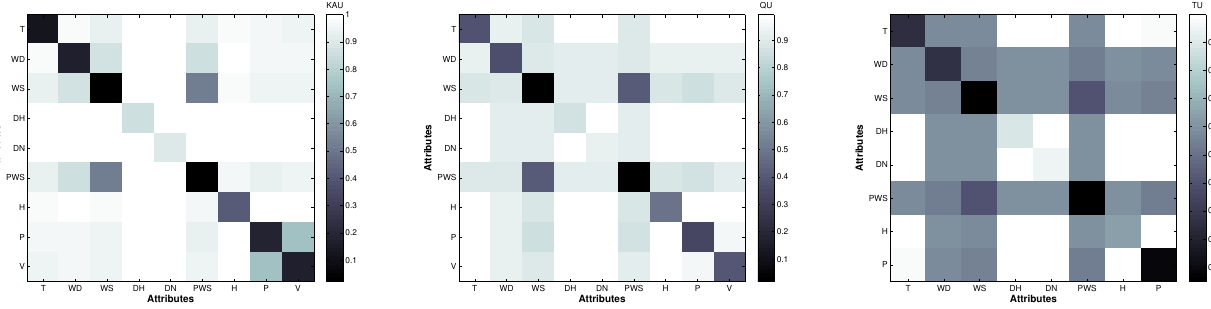
Figure 7. The real values of the decision attribute: Distributions of γ -values of reducts with dual and single attributes.